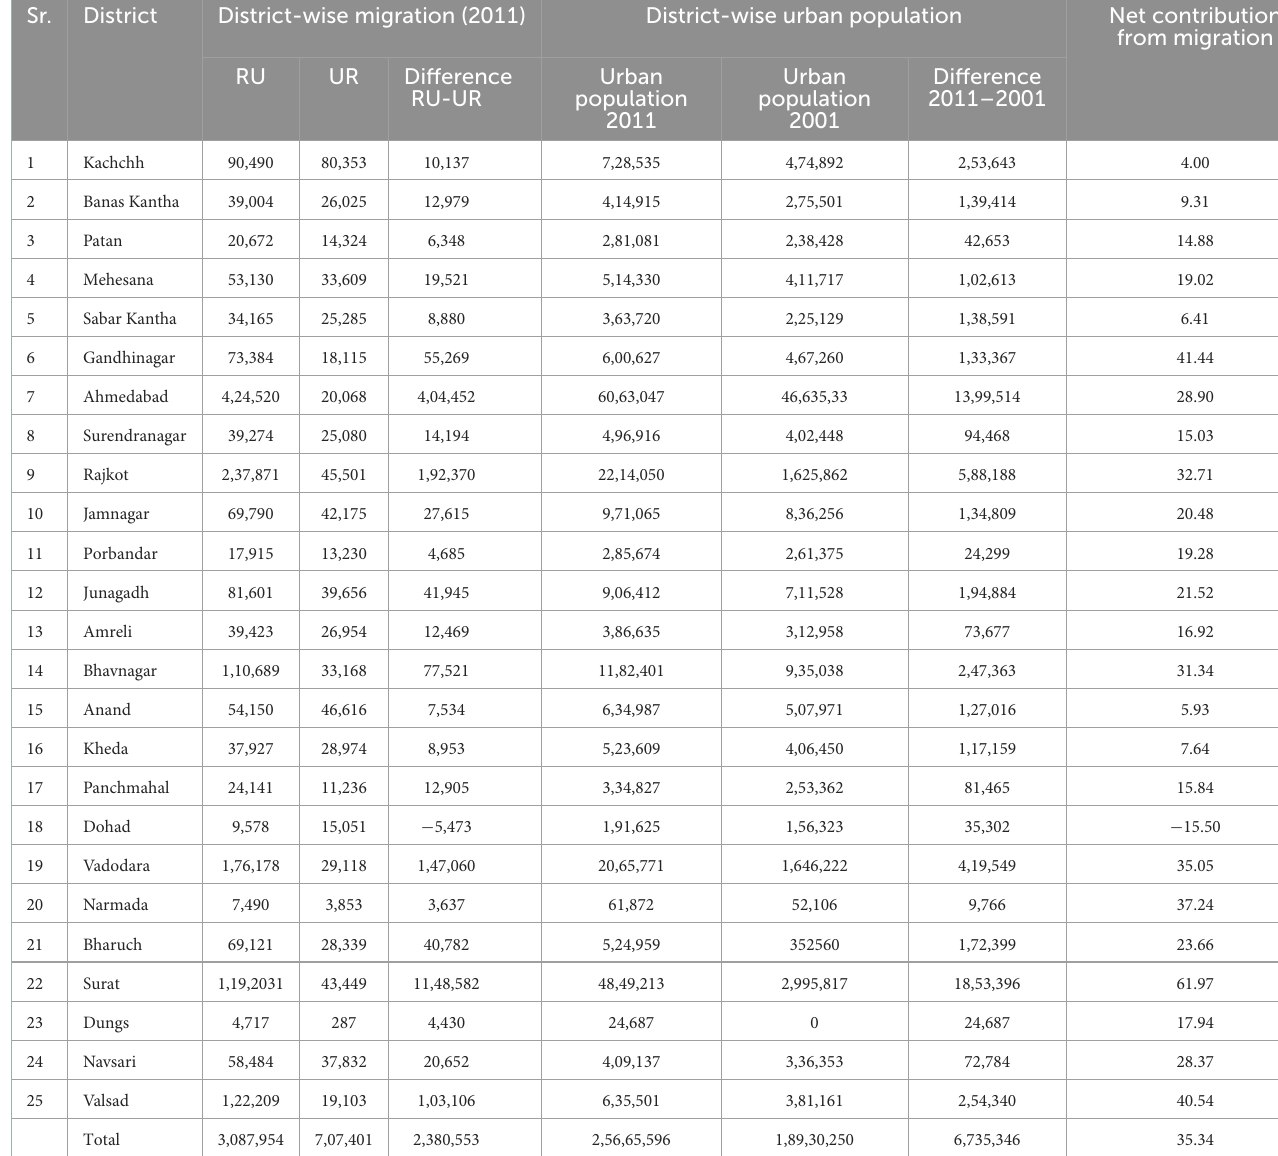
TABLE 12 District-wise net contribution of urbanization from migration, 2001–2011.